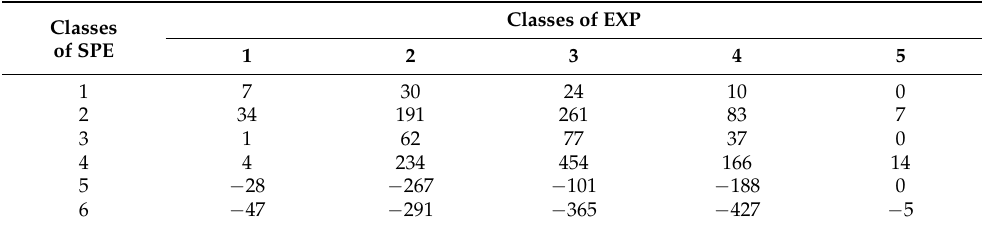
Table 12. Percentage difference (C2 values–C1 values) in the number of LAUs falling in each combination of five EXP classes and six SPE